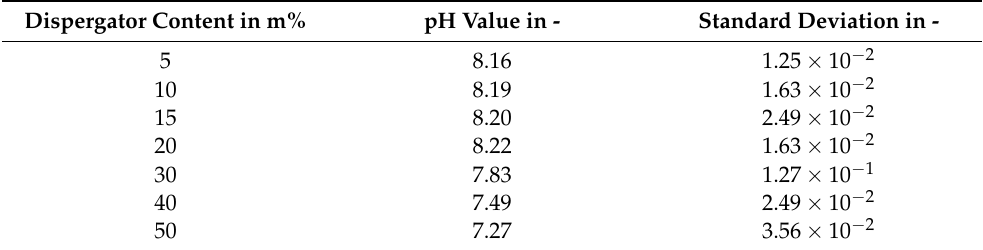
Table A7. PH values as a function of PVP content for a solution with no nanoparticles. Dispergator Content in m%